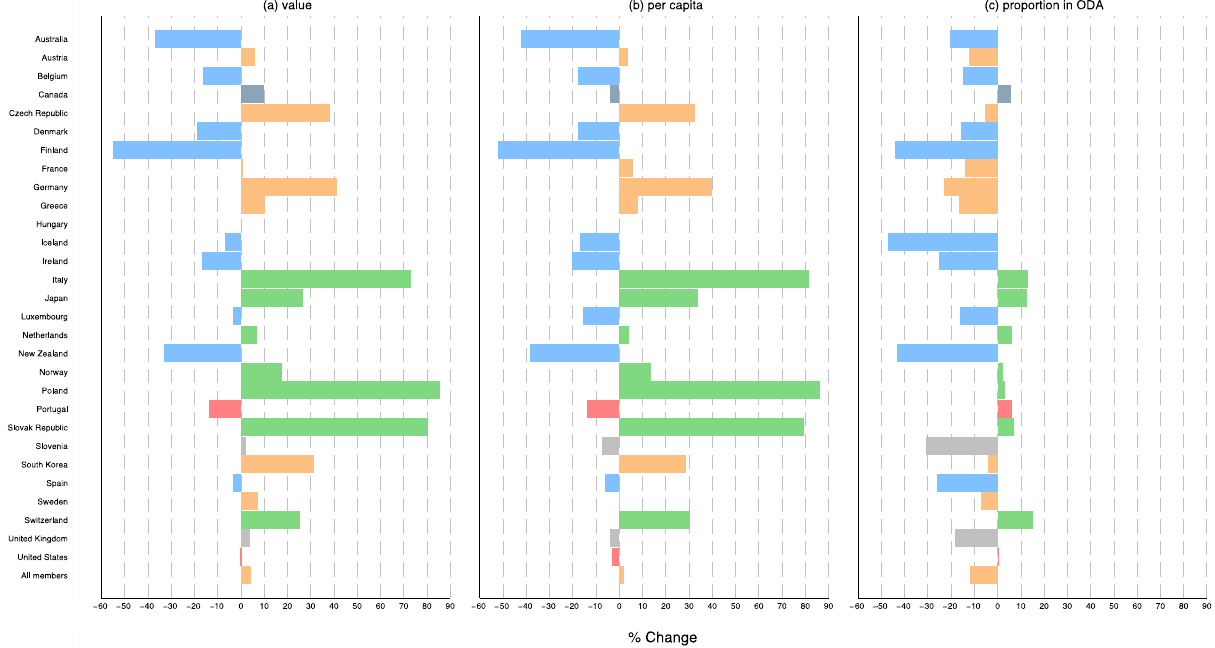
Figure 2. Percentage change in the average of estimated DAH for 2016–2019 from 2011–2014 for all the 29 DAC member countries: ( a ) value, ( b ) per capita and ( c ) proportion of DAH in ODA. Blue: all decreased; Red: ( a , b ) decreased and ( c ) increased; Gray: ( a ) increased and ( b , c ) decreased; Orange: ( a , b ) increased and ( c ) decreased; Navy: ( a , c ) increased and ( b ) decreased; Green: all increased; DAH: development assistance for health; DAC: Development Assistance Committee; ODA: official development assistance.